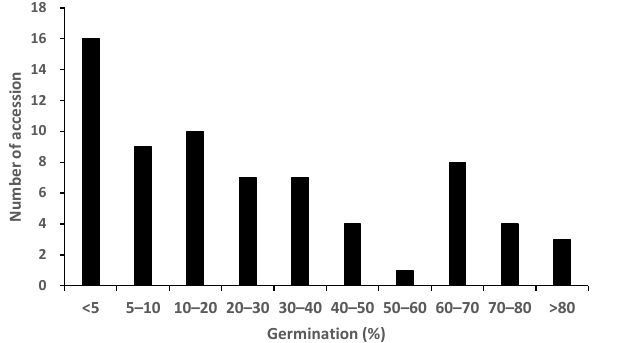
Figure 2. Frequency distribution of 69 accessions in World Rice Core Collection for percentage of germination ‐ inducing activity of root exudates (pre ‐ attachment resistance).